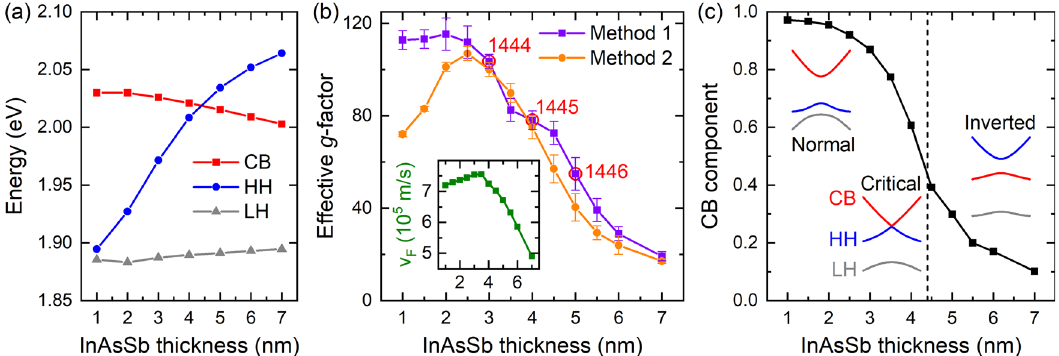
work, where t InAsSb =3nm, 4nm, and 5nm, respectively. Inset: TheextractedFermi velocity v F fromthefour-bandmodelasafunctionof t InAsSb . c TheCBcomponentin the wavefunctionasafunction of t InAsSb . Thecalculationisperformedat1T.Insets: Band evolution from the normal state to the inverted state as increasing the SL period. The critical state is indicated by a vertical dash